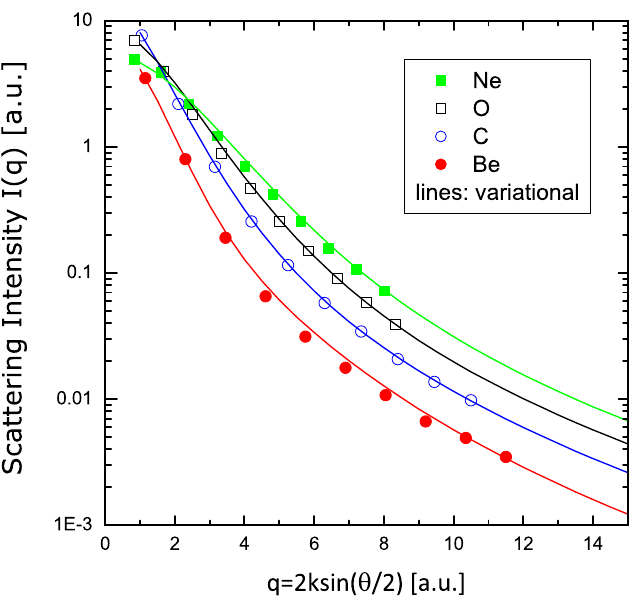
Figure 7. Scattering intensity of electrons in Be, C, O, and Ne, according to Equation (48). The symbols are the calculations reported in Ref. [36]; the lines are the results of the variational calculations with two parameters.